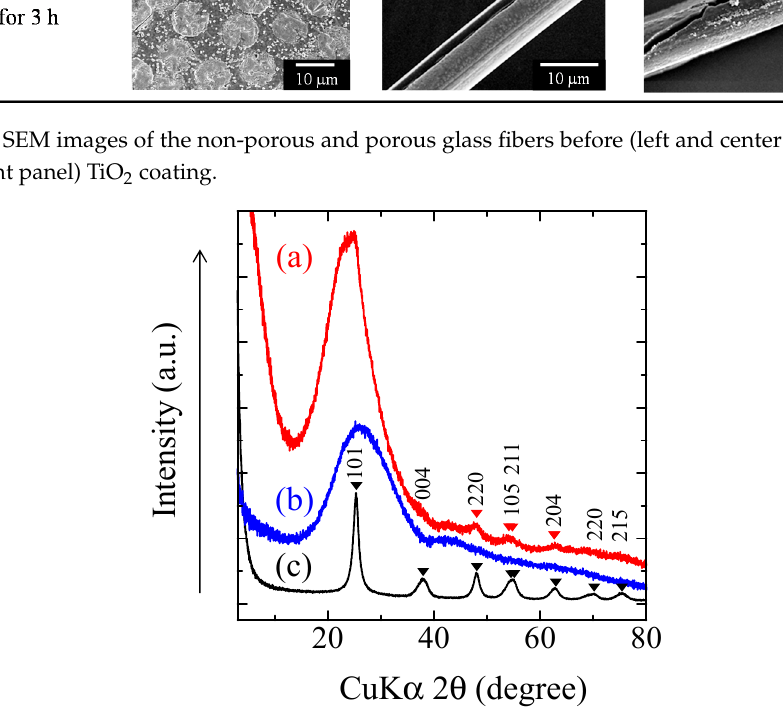
Figure 2. Powder X-Ray diffraction (XRD) pattern of the ground samples: ( a ) dried and heated TiO 2 suspension; ( b ) TiO 2 -coated non-porous glass cloth; and ( c ) TiO 2 -coated porous glass cloth. hkl are reflection indices of anatase.